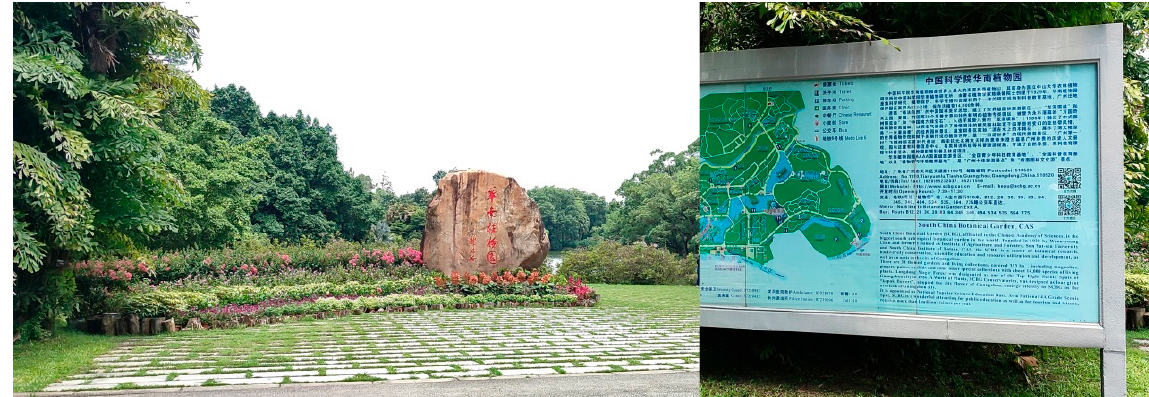
Figure 1. Entrance of Southern China Botanical Garden.